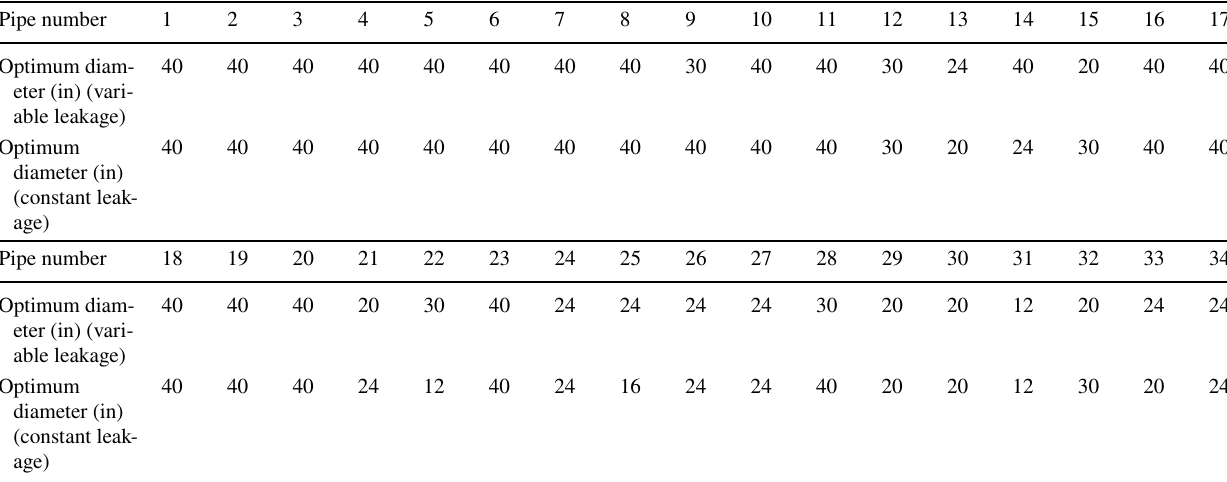
Table 10 Comparison of the optimal diameters of the three-loop WDN calculated with constant leakage and variable leakage Pipe